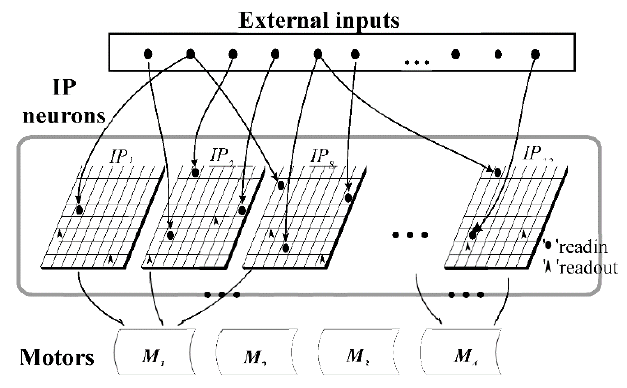
Figure 7. Interface between the ANM system and Snaky.